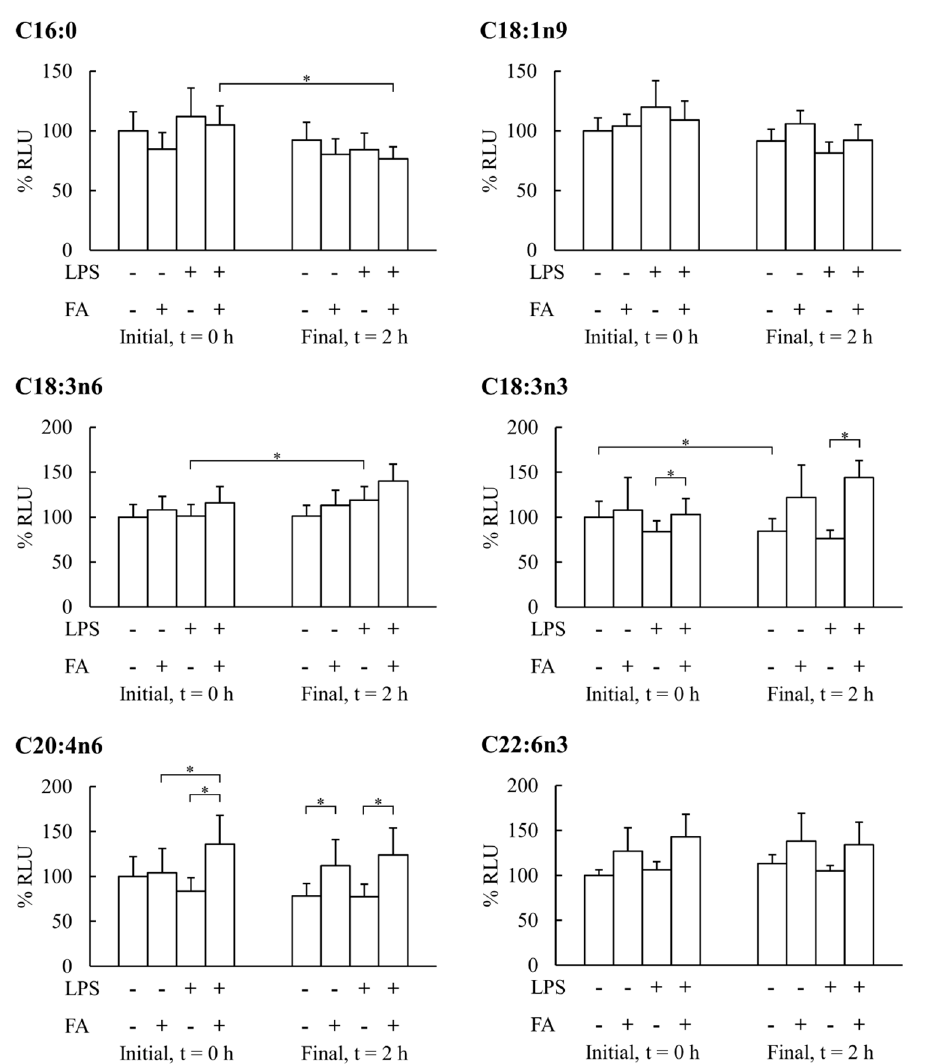
Figure 2. Hydrogen peroxide production by LPS-stimulated PBMCs before and after PBMCs’ incubation with 50 µ M of either fatty acid palmitic (C16:0), oleic (C18:1n9), γ -linolenic (C18:3n6), α -linolenic (C18:3n3), arachidonic (C20:4n6), or docosahexaenoic (C22:6n3), or LPS or LPS plus one fatty acid. Statistical analysis: Paired sample t -test, p < 0.05. * Significant differences ( p < 0.05) between the groups involved.